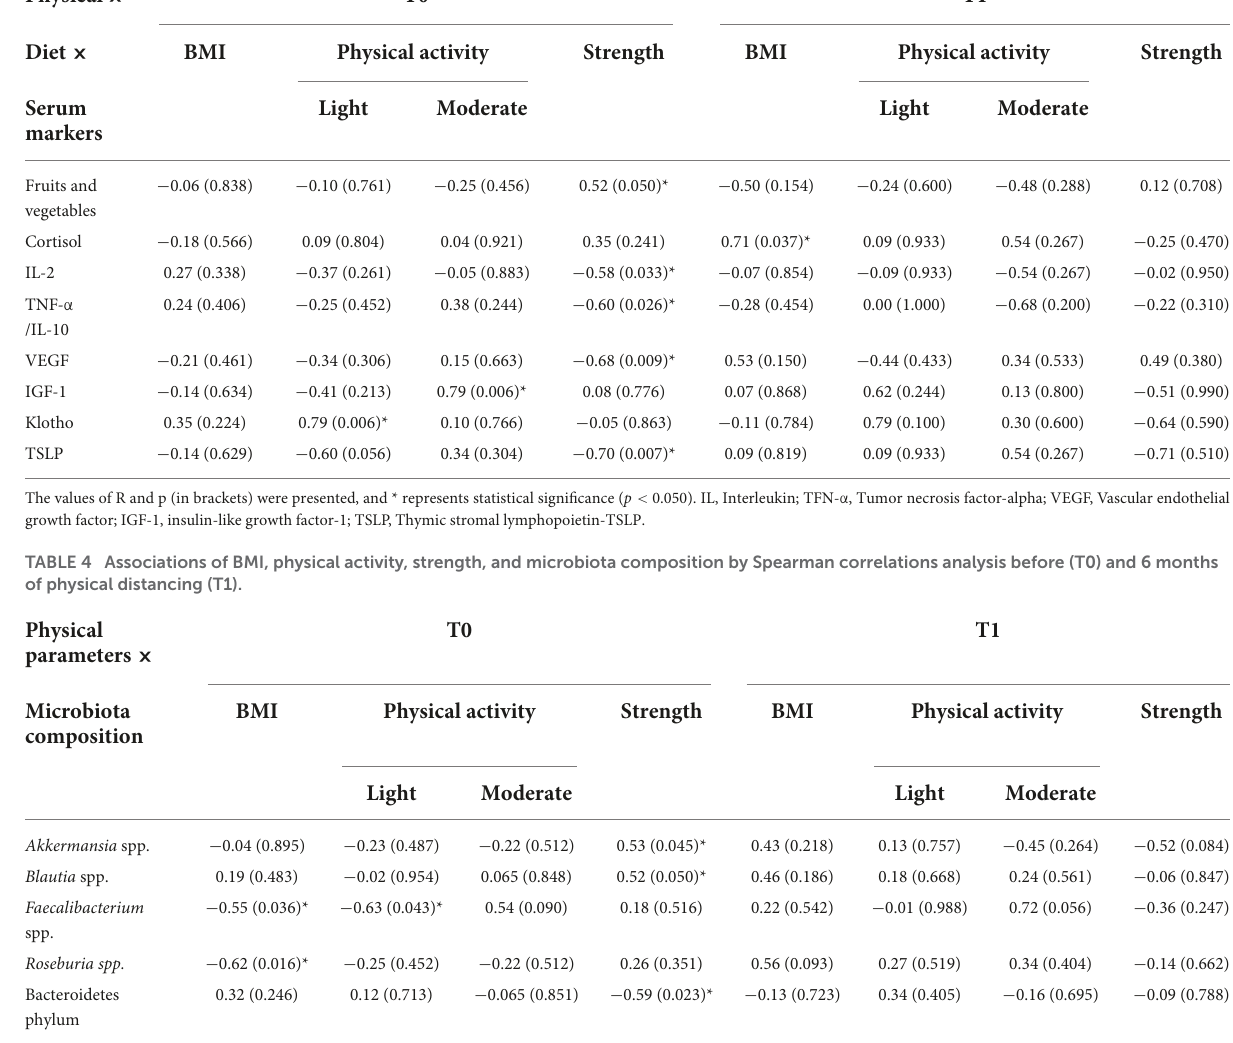
Faecalibacterium